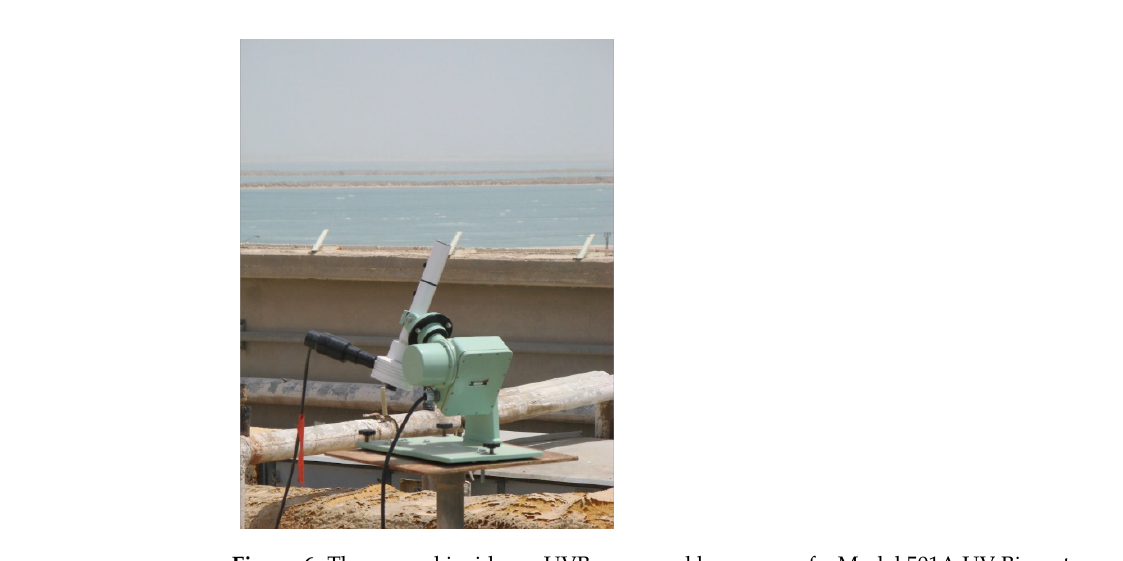
Figure 6. The normal incidence UVB measured by means of a Model 501A UV-Biometer mounted on an Eppley Solar Tracker Model St-1.